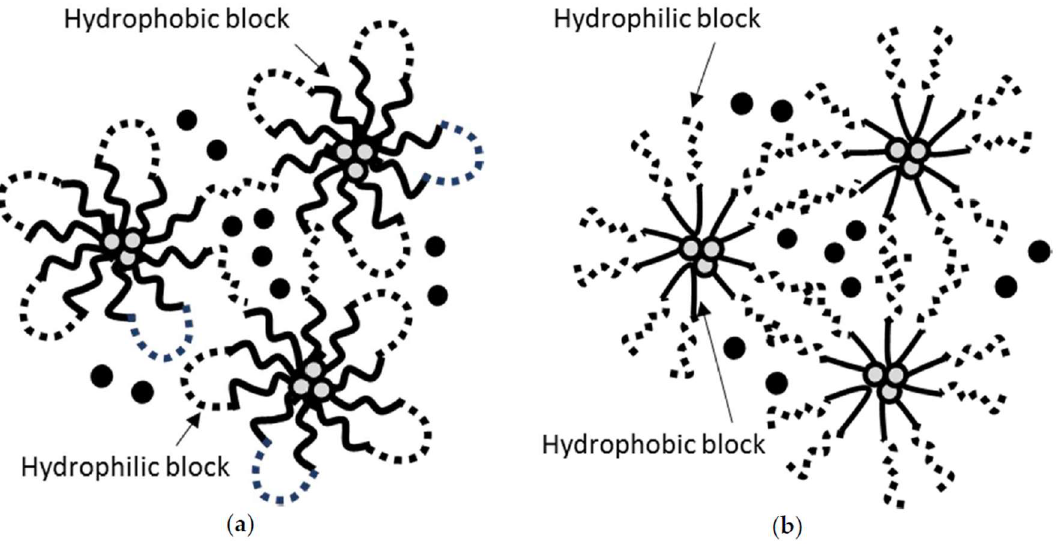
Figure 1. Schematic illustration of nanogels loaded with hydrophilic (solid circle) and hydrophobic (light grey circle) drugs using ( a ) BAB (hydrophobic-hydrophilic-hydrophobic) block copolymers or ( b ) ABA (hydrophilic-hydrophobic-hydrophilic) block copolymers.